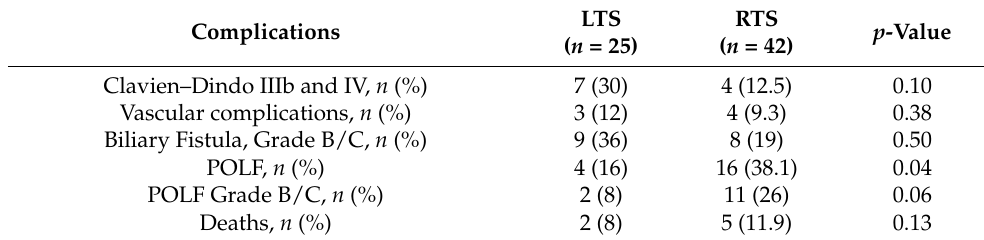
Table 2. Perioperative (90 days) surgical complications.